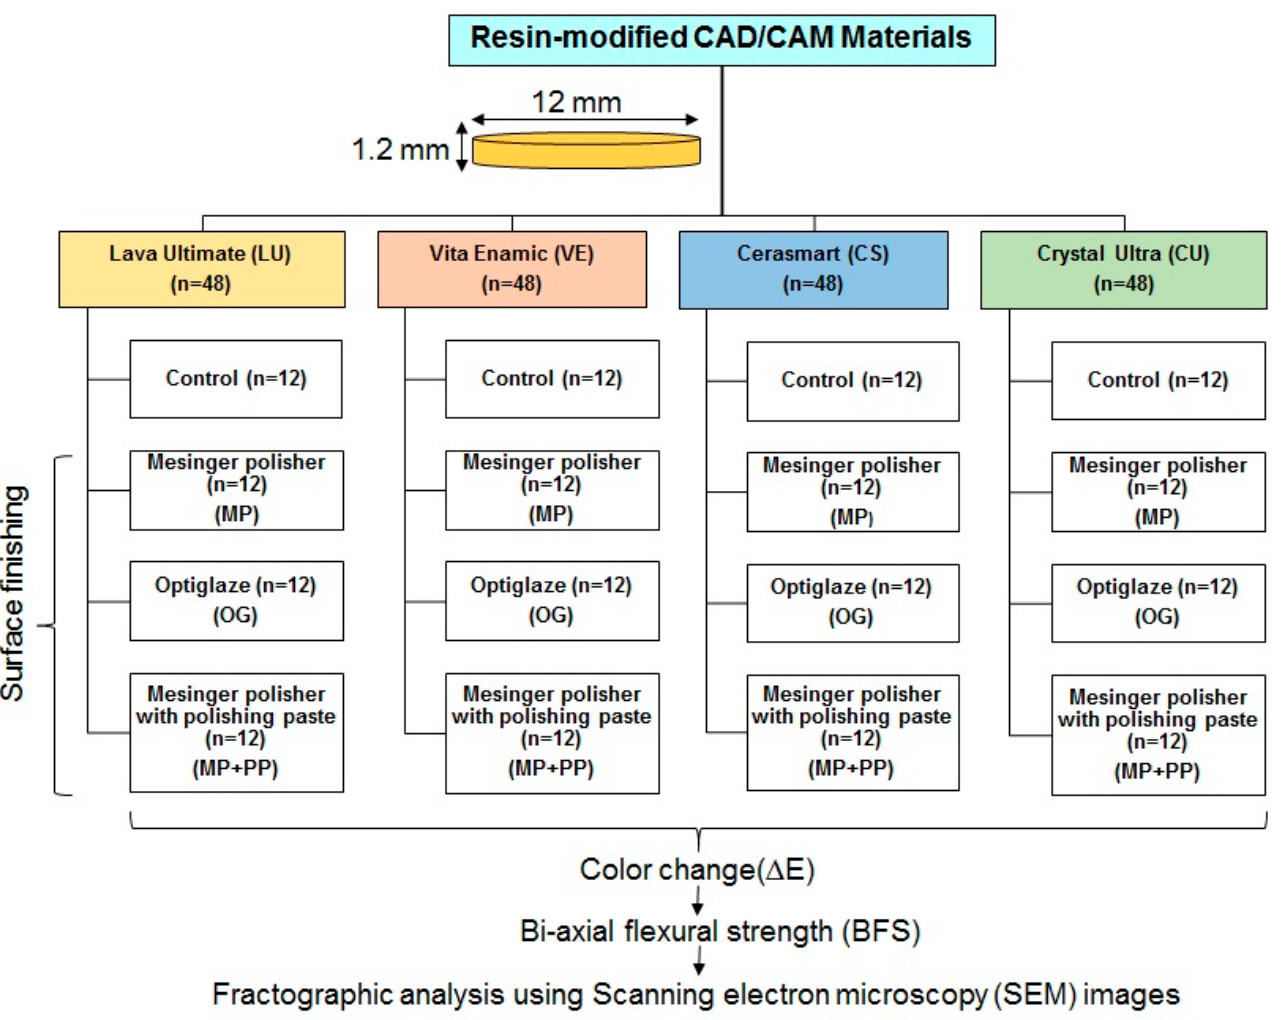
Figure 1. Flowchart showing group allocation and study procedure. Table 2. Surface finishing kits used in this